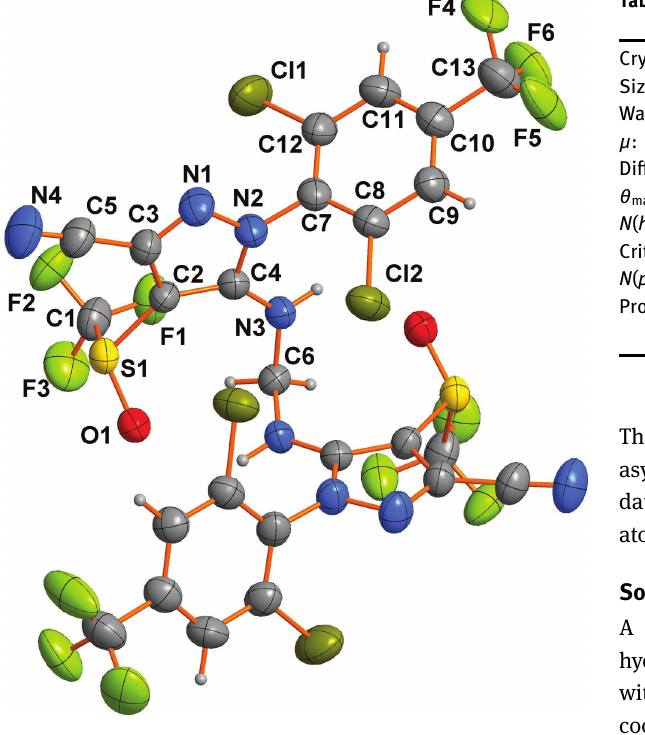
Table 1: Data collection and